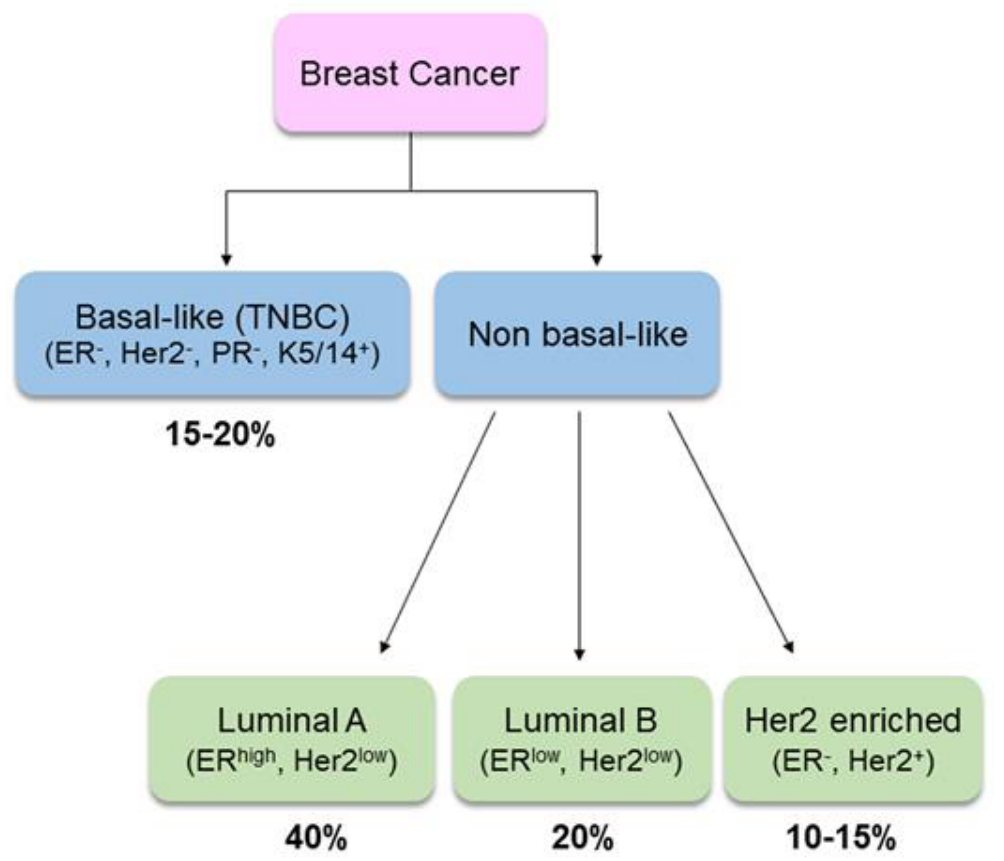
Figure 1. Breast cancer sub-types and relative prevalence. TNBC: triple negative breast cancer [12].